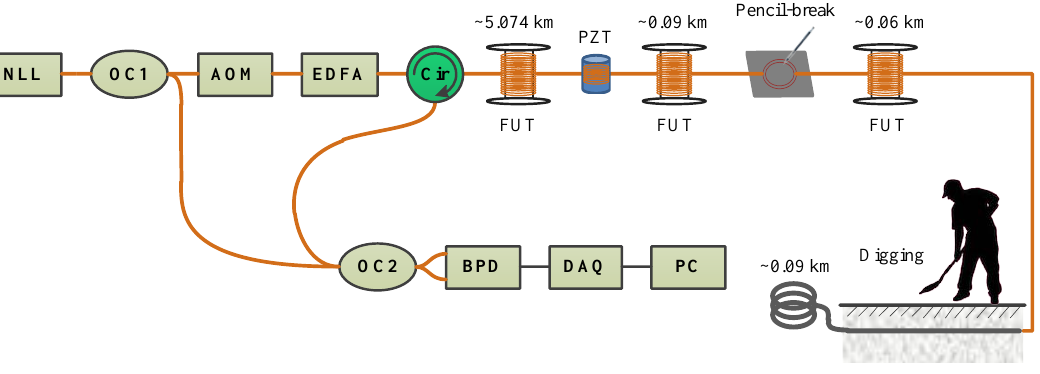
Figure 3. The experimental setup. NLL: narrow line-width laser; OC: optical coupler; AOM: acoustic-optic modulator; EDFA: Erbium-doped fiber amplifier; Cir: circulator; FUT: fiber under test; BPD: balanced photo detector; DAQ: data acquisition; PC: personal computer.